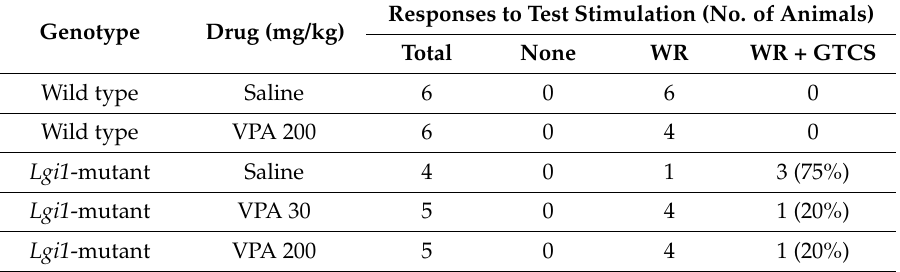
Figure 6. Prophylactic effects of valproic acid (VPA) on audiogenic seizure susceptibility. Animals were intraperitoneally injected with VPA (30 mg/kg and 200 mg/kg) or saline for 14 continuous days from P15 (one day before priming stimulation). Table 2. The responses to acoustic test stimulation at eight weeks in wild-type rats and Lgi1 mutant rats treated with VPA. WR: wild running; GTCS: generalized tonic–clonic seizure.